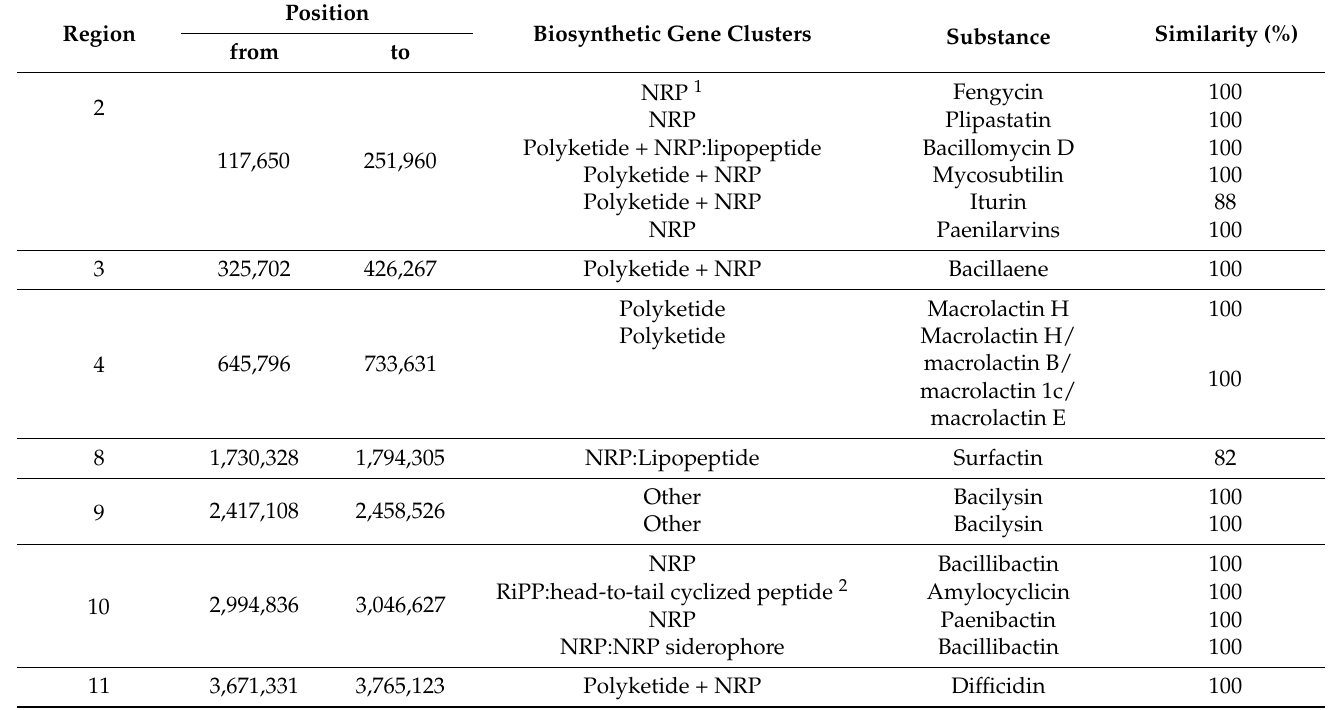
Table 7. The secondary metabolite gene clusters in the isolate B3 obtained using anti-SMASH. Position Region Biosynthetic Gene Clusters Substance Similarity (%) from to